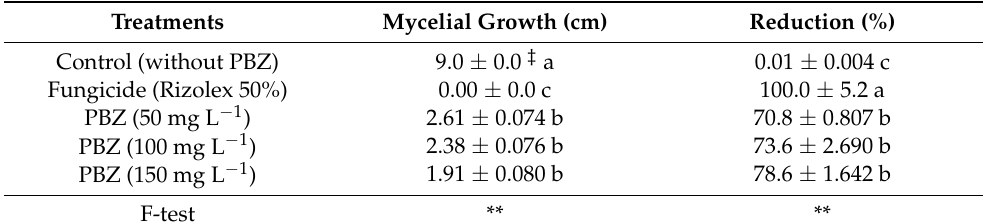
Table 3. The inhibition rate of R. solani mycelial growth by applied PBZ under different doses on PDA medium.